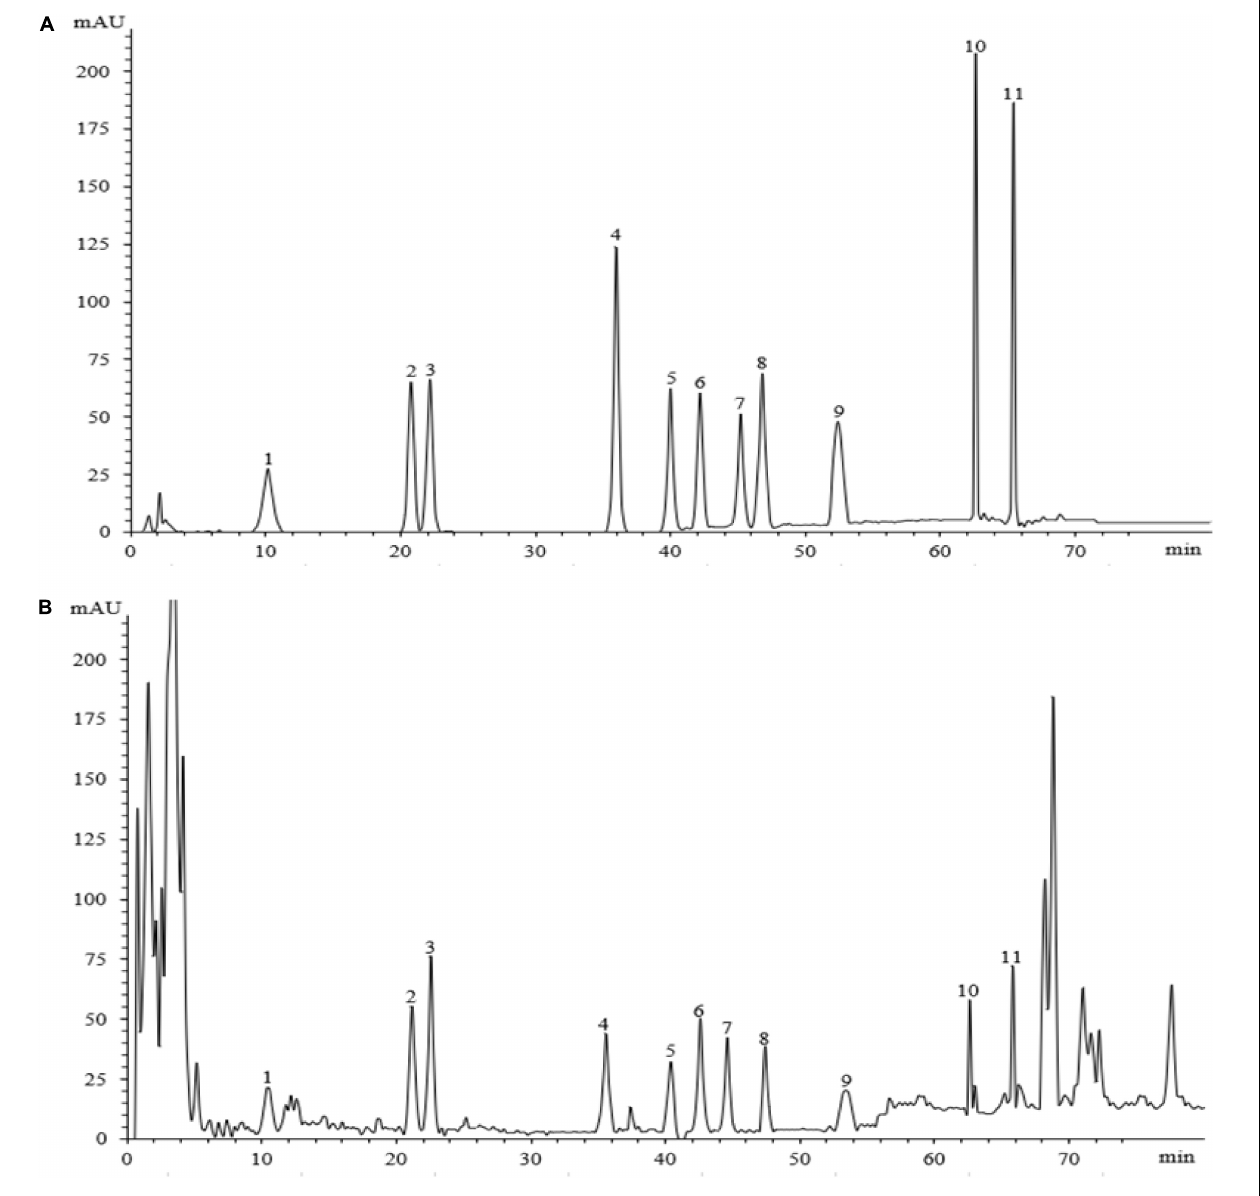
FIGURE 2 | The HPLC chromatograms of the standard and sample. Panel (A) shows the chromatographic peak of the standard substance, panel (B) shows the chromatographic peak of the ginseng root sample. The peaks 1–11 represent ginsenosides-Ro, -Rg1, -Re, -Rf, -Rb1, -Rc, -Rb2, -Rb3, -Rd, -Rh2, and